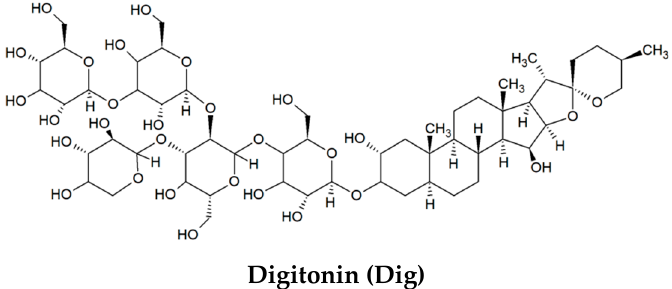
Figure 1. Chemical structures of compounds (and their abbreviations) used in this study.